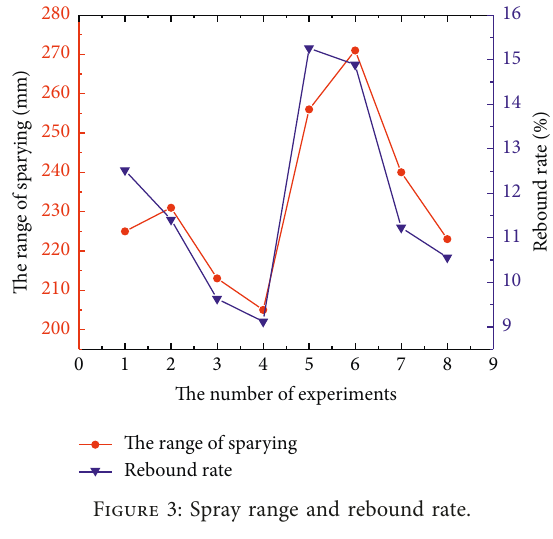
Figure 3: Spray range and rebound rate.